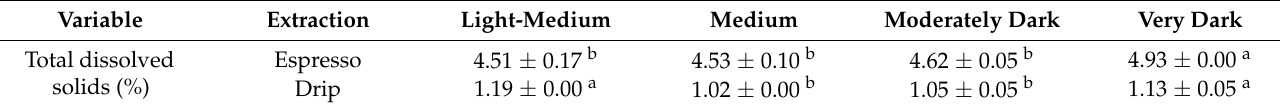
Table 2. Total soluble solids in coffee extracts.